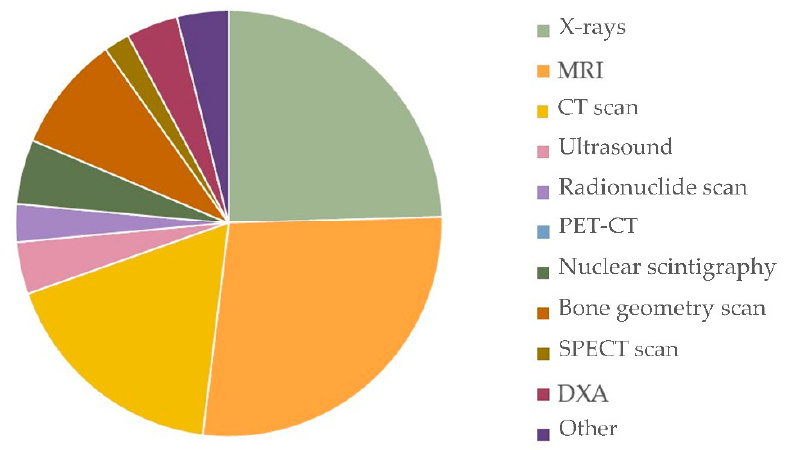
Figure 9. Imaging